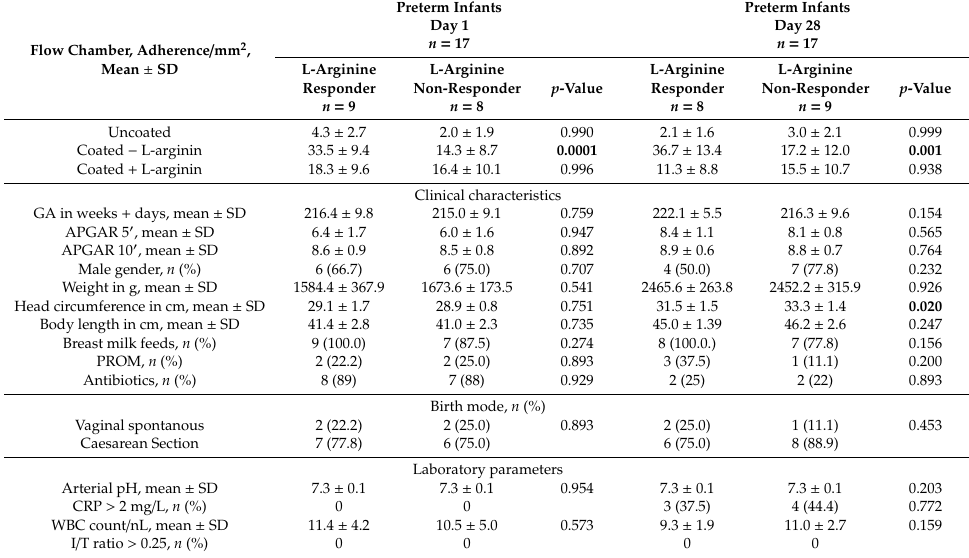
Figure 4. Leukocyte adhesion correlates with postnatal development. Leukocyte adherence from microflow chamber experiments from the n = 17 preterm infants at day 1 and day 28 of life was correlated to gestational age (in days). Linear regression showed a significant correlation (Pearson r = 0.612). Data are presented as individual data points with linear regression (solid line) and 95% confidence intervals (dashed line). Table 2. Basic and clinical characteristics of preterm infants depending on L-arginine response at birth and on day 28. Subgroups are divided by the mean reduction in leukocyte adherence by L-arginine (L-arginine response) for each time point (day 1, 28). Categorical variables are reported as n (%) and continuous variables are reported as mean with SD. Group comparison were performed using Chi-square for categorical variables and by Student’s t -test for continuous variables. Adherence from microflow chamber experiments was compared by two-way ANOVA and Tukey’s post hoc analysis. p -values < 0.05 were considered statistically significant and are marked in